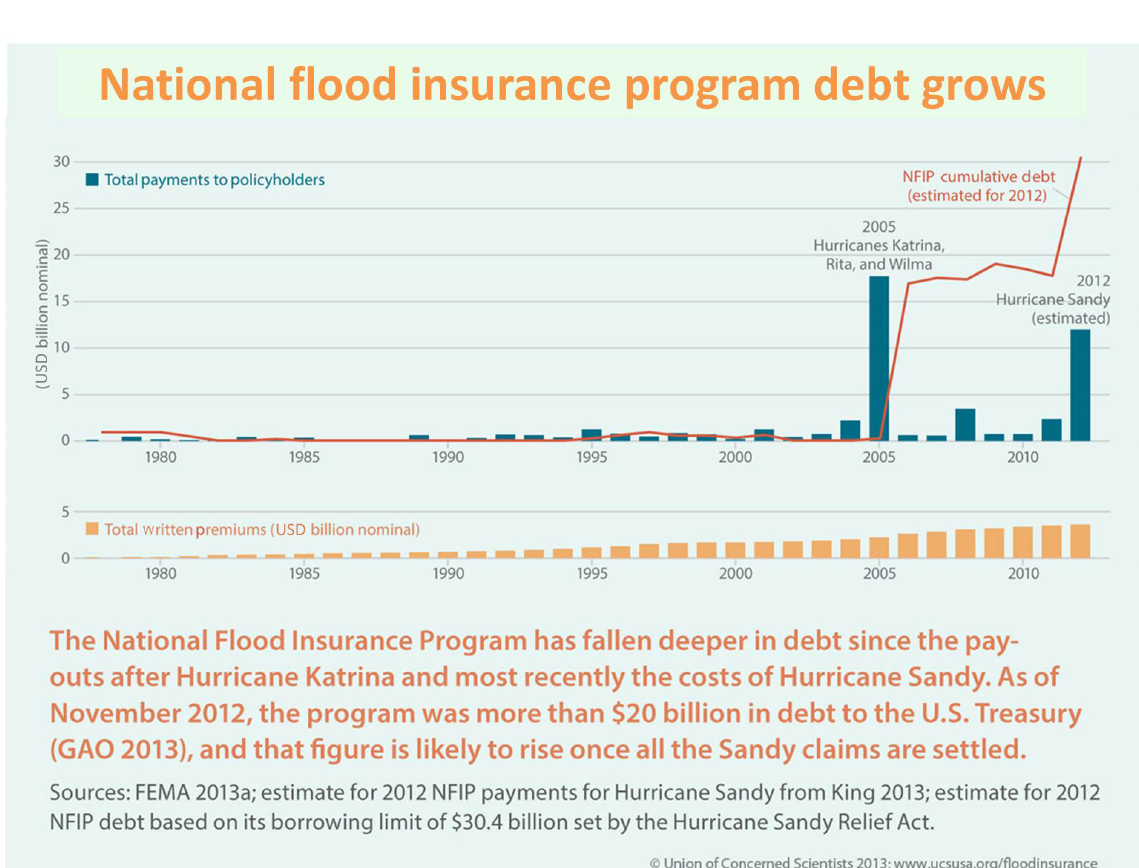
Figure C1. NFIP cumulative debt, total payments and total premiums,